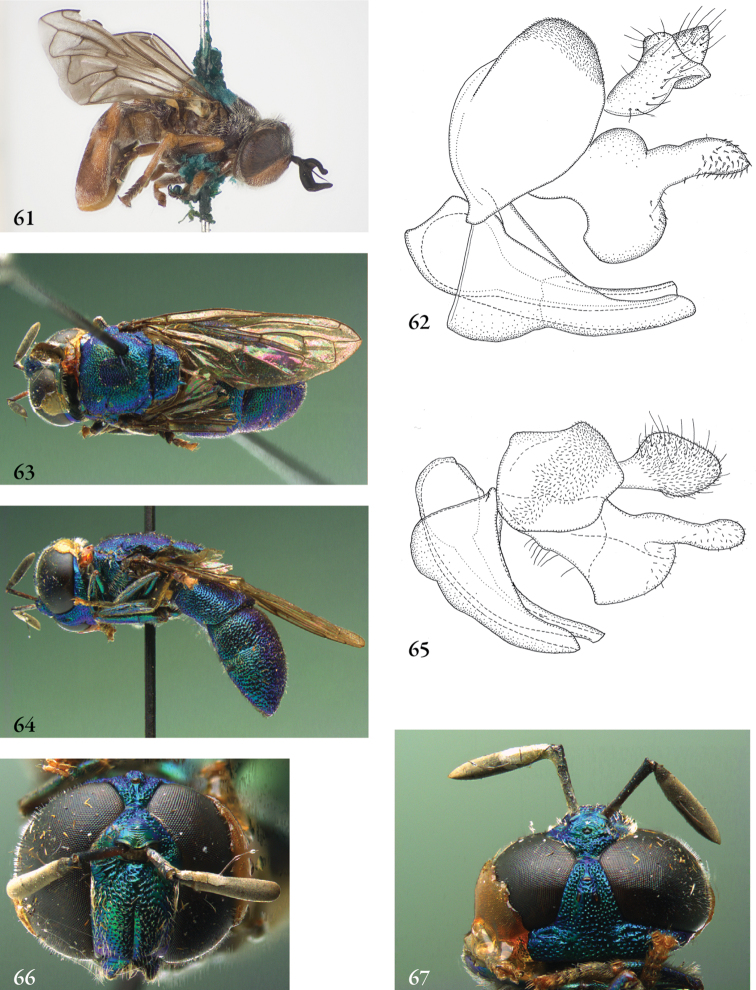
61–62
Cervicorniphora alcicornis male (Australia, coll. USNM): 61 habitus lateral 62 genitalia lateral 63–65
Chrysidimyia chrysidimima male (holotype): 63 habitus dorsal 64 habitus lateral 65 genitalia lateral 66–67
Chrysidimyia chrysidimima male (holotype): 66 head frontal 67 head lateral.